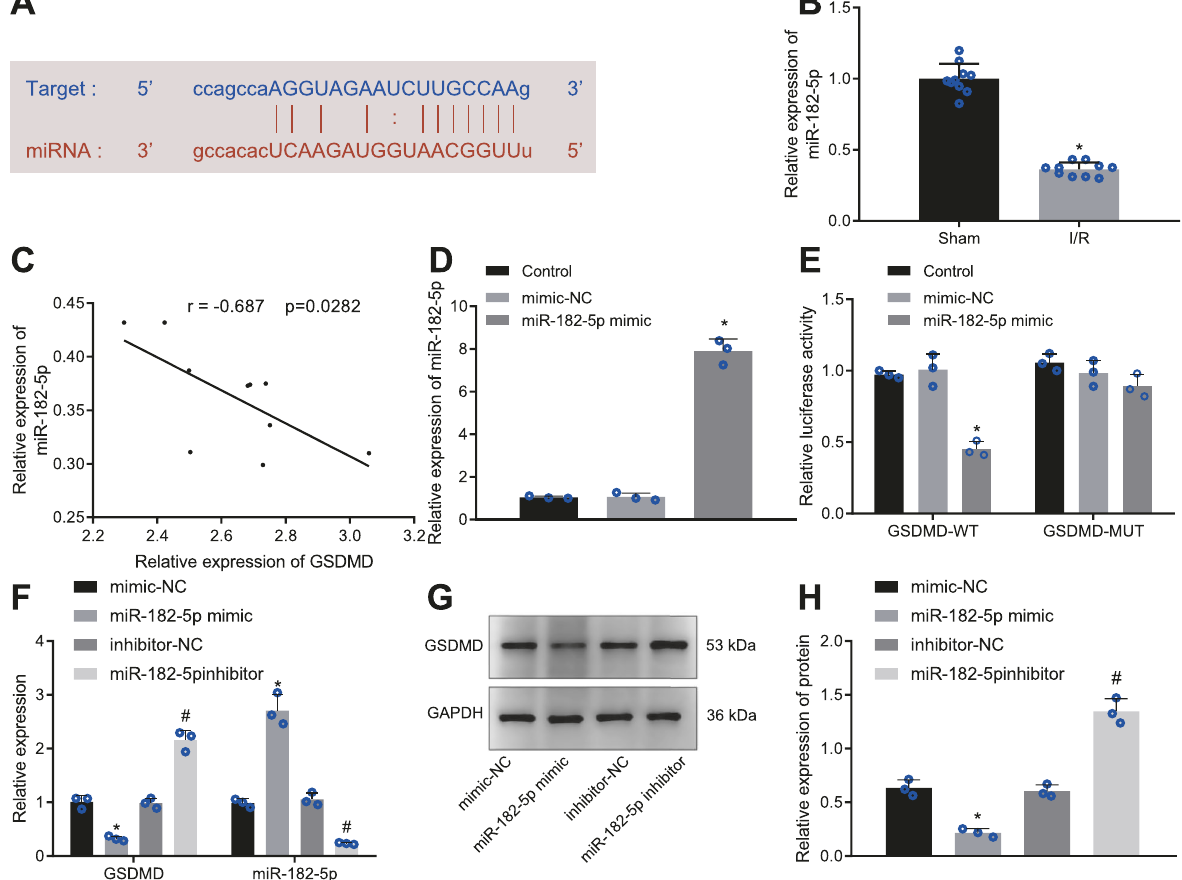
Fig. 4 miR-182-5p targets GSDMD. A miR-182-5p putative binding sites in GSDMD 3 ′ UTR predicted by starBase; B The relative expression of miR-182-5p in I/R-injured myocardial tissues detected by RT-qPCR, normalized to U6; C The correlation of miR-182-5p expression with GSDMD expression in I/R-injured myocardial tissues; D The miR-182-5p expression in myocardial cells determined by RT-qPCR; E The binding of miR- 182-5p to GSDMD in HEK-293T cells con fi rmed by dual-luciferase reporter assay; F The miR-182-5p expression and relative mRNA expression of GSDMD in myocardial cells detected by RT-qPCR; G Representative images of GSDMD protein bands; H Western blot analysis of GSDMD protein in myocardial cells, normalized to GAPDH. N = 10 for mice in each group. Measurement data were expressed as mean ± standard deviation. The comparison between two groups was conducted by unpaired t -test. Each cell experiment was repeated three times independently. * P < 0.05 vs. sham-operated mice or HEK-293T cells or myocardial cells transfected with mimic-NC, # P < 0.05 vs. myocardial cells transfected with